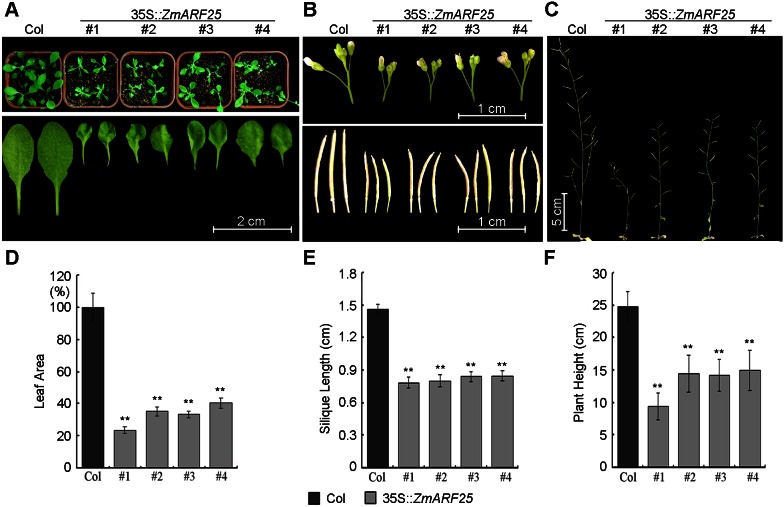
Morphology of 35S::ZmARF25 and wild-type plants.Morphology of (A) leaf size, (B) Inflorescences, flowers and siliques and (C) plant height. Statistics of (D) fully expended fifth leaves area, (E) siliques and (F) plant height. Col represents the wild-type; #1–4 represent the four 35S::ZmARF25 transgenic lines; data are represented as the mean ± SE (n = 10). t-test compared with the wild-type control: **refers to significant at p<0.01.